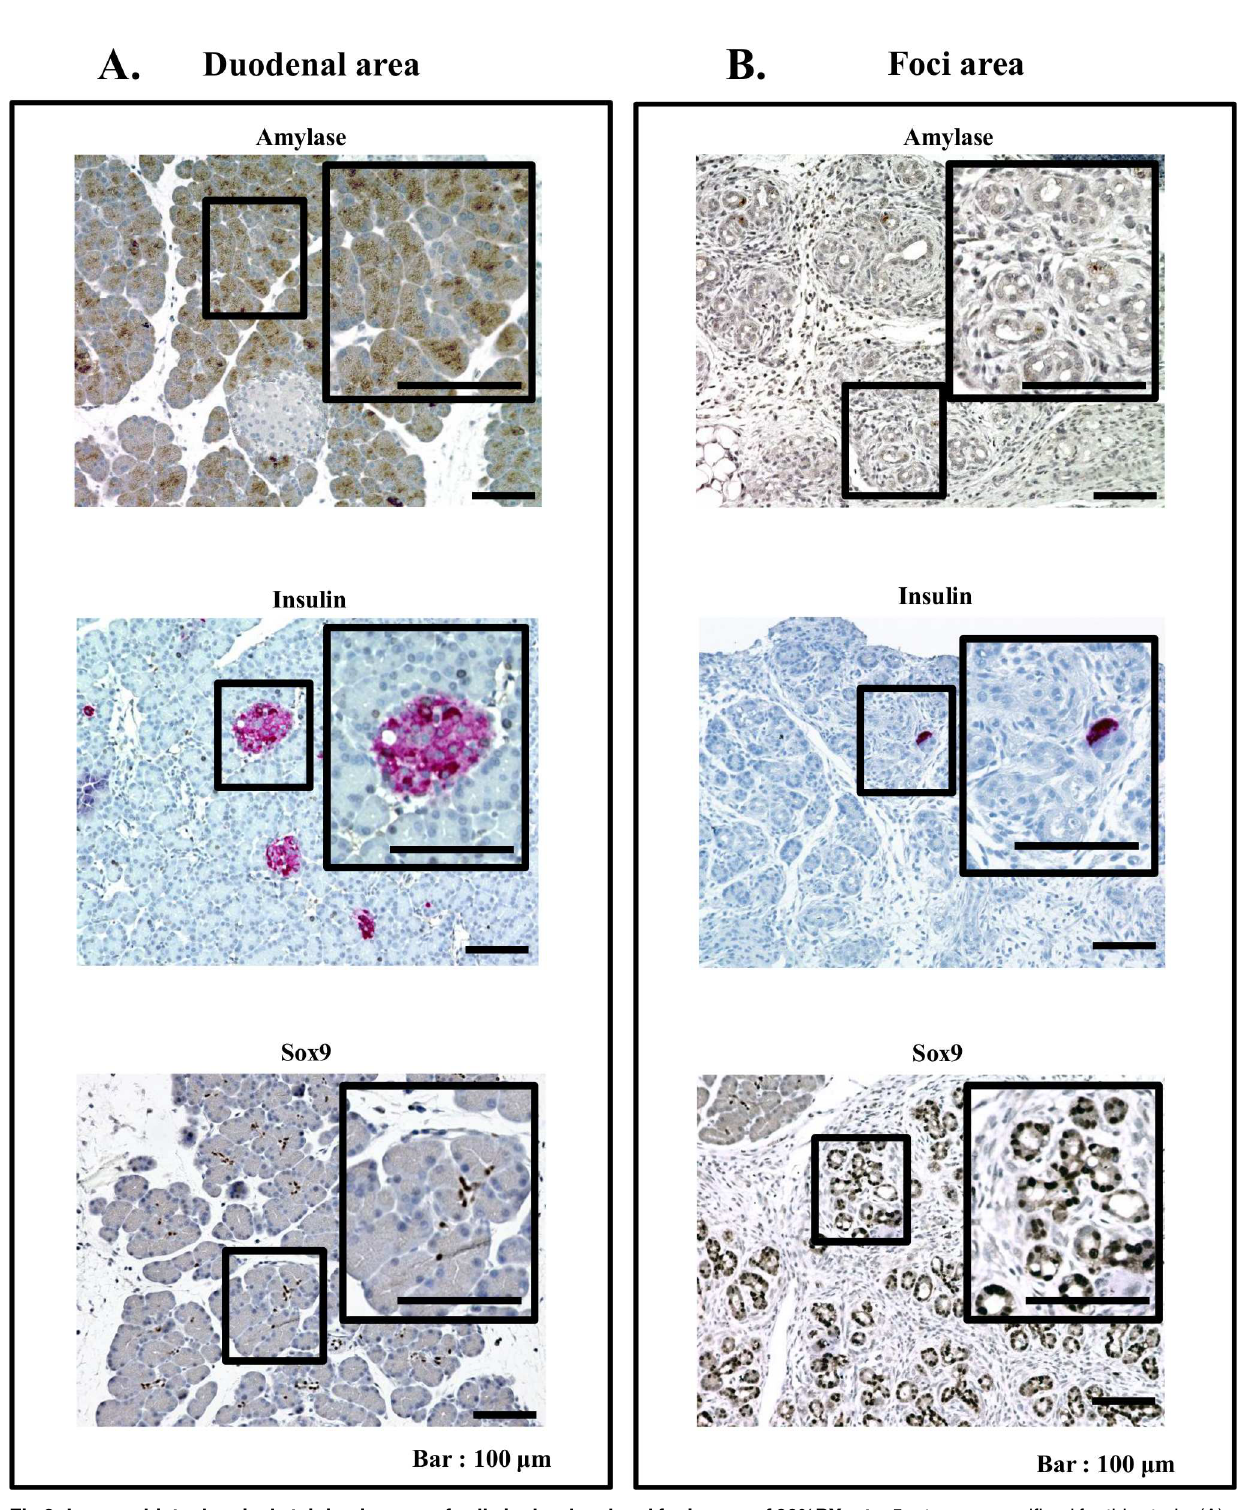
Fig 2. Immunohistochemical staining images of cells in duodenal and foci areasof 90%PX rats. 5 rats were sacrificed for this study. (A) Representative immune stainingimages of amylase (aciner cells), insulin(islet) and sox9 (centro-acinar cells) in duodenal area. (B) Representative immuno-staining images of amylase, insulinand sox in foci area. Note, unlikethose in duodenal area, relatively weak stainingof ductule-like cells for amylase, very little staining of islet cells for insulinand clear staining of ductule-likefor sox9 cells.